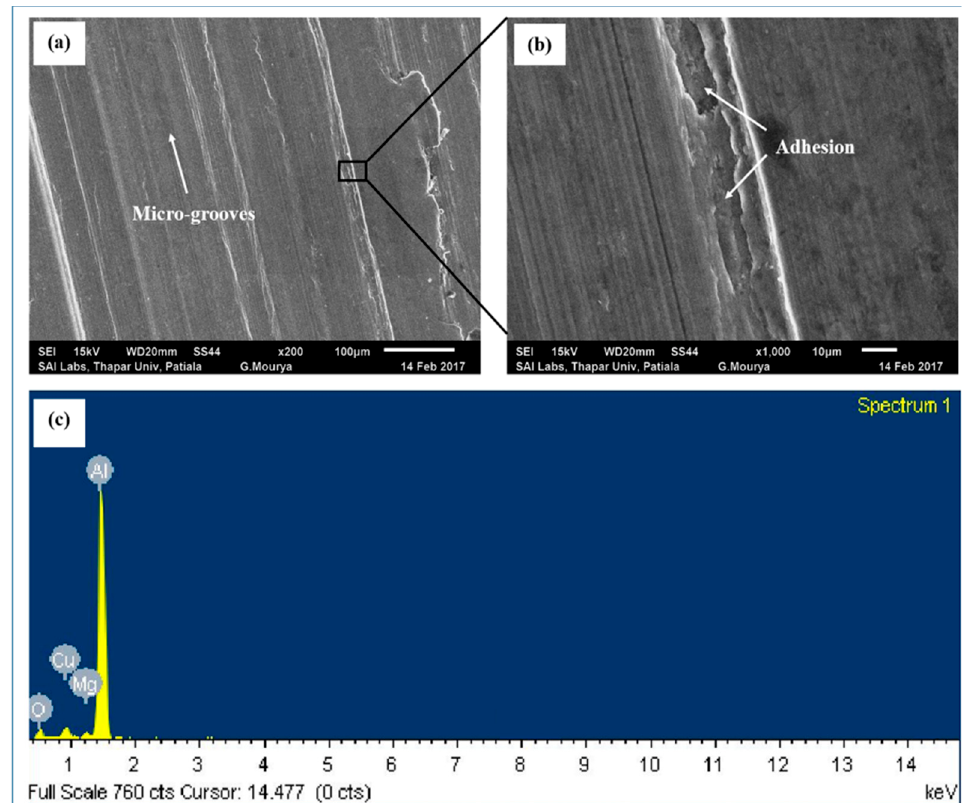
Figure 4. ( a ) SEM image of worn surface of the aluminium alloy disc lubricated with PAO base oil at 50 N load (200×); ( b ) magnified image (1000×) of Figure 4a; and ( c ) EDS spectrum of Figure 4a. Worn surface shows micro-grooves and occurrence of adhesion.